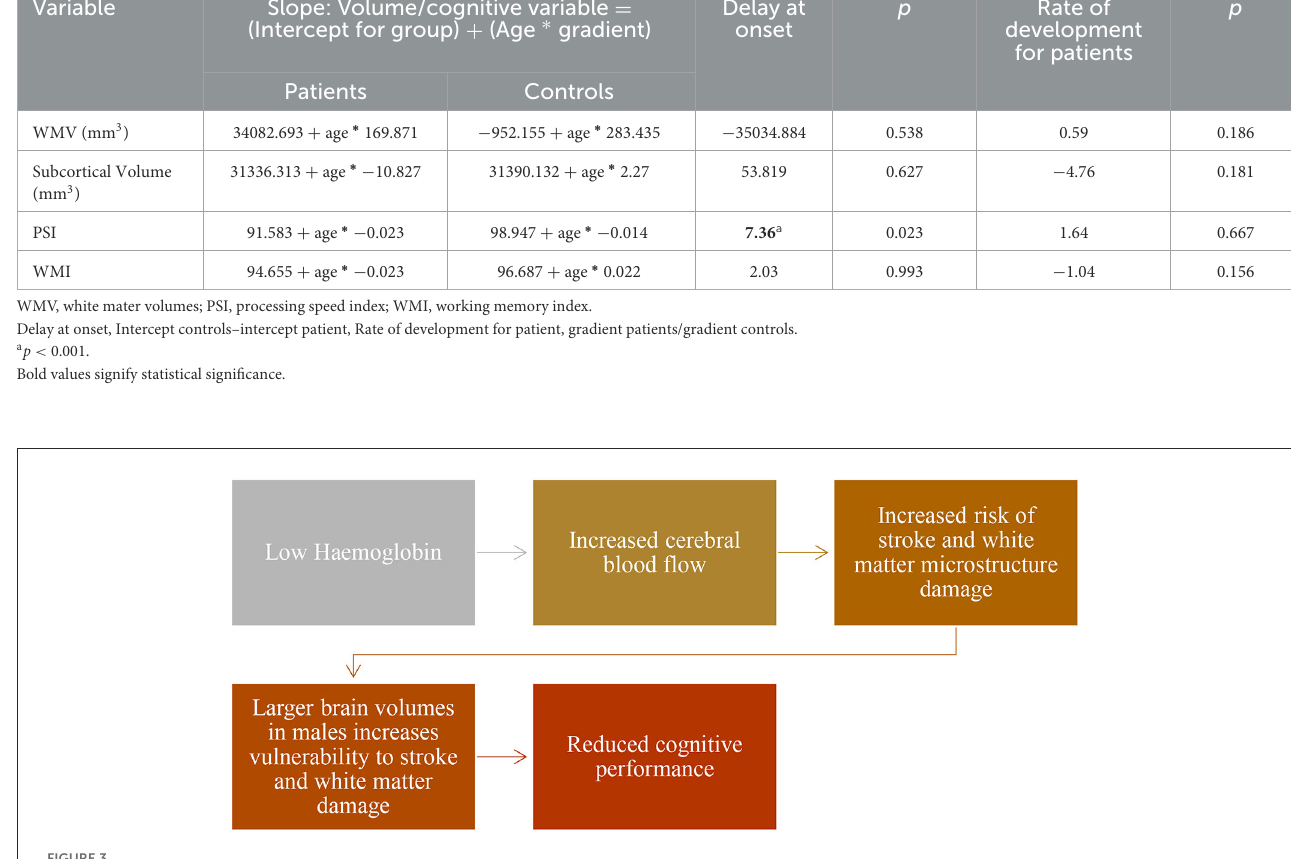
FIGURE3 Beyond brain